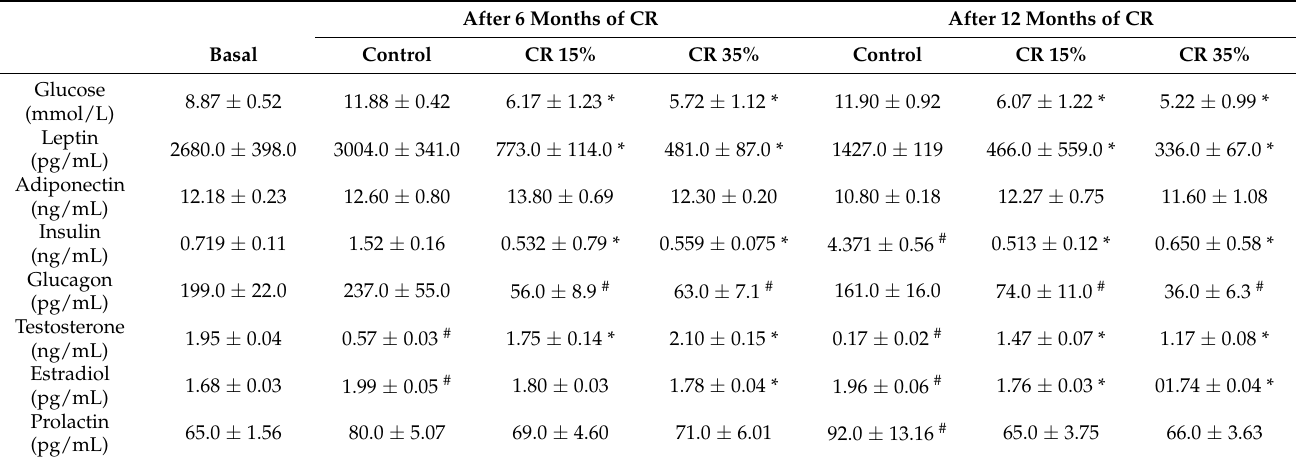
Table 4. Effect of CR on metabolic parameters in aged male Wistar